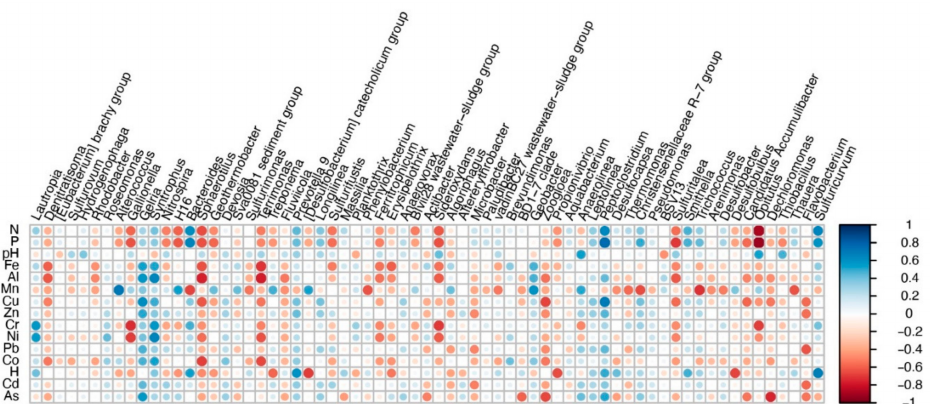
Figure 2. Pearson co-correlation plot (2%) showing the response of bacterial taxonomy according to the concentrations and spreading of nutrients, pH and